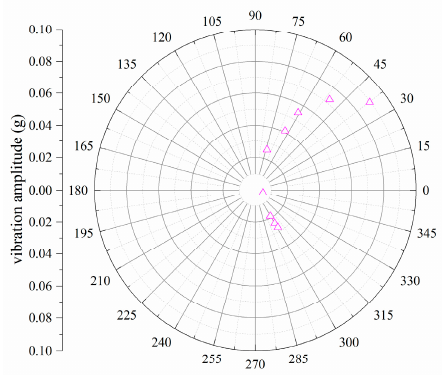
Figure 19. Longitudinal amplitude diagram of pitch.